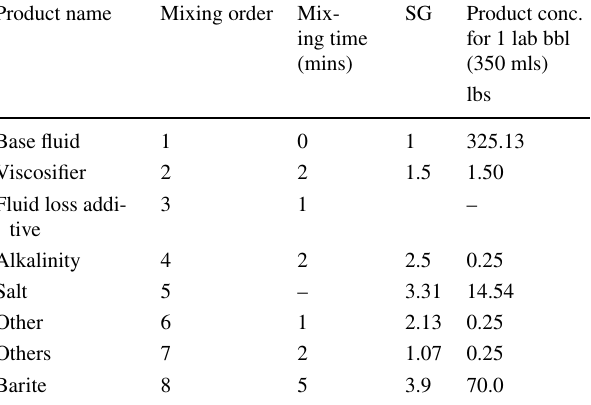
Table 2 Laboratory formulation for preparation of equivalent to 1 barrel of WBM